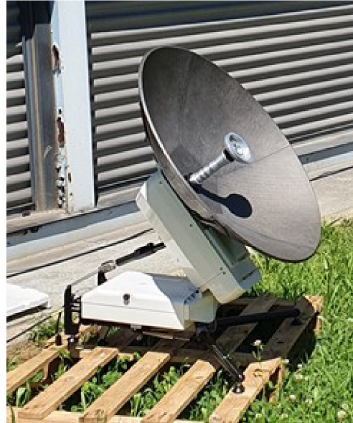
Figure 14. B-LiFE deployment in Turin, Italy, during the COVID-19 crisis: installation of the GovSat Scorpion MP80X SatCom terminal.